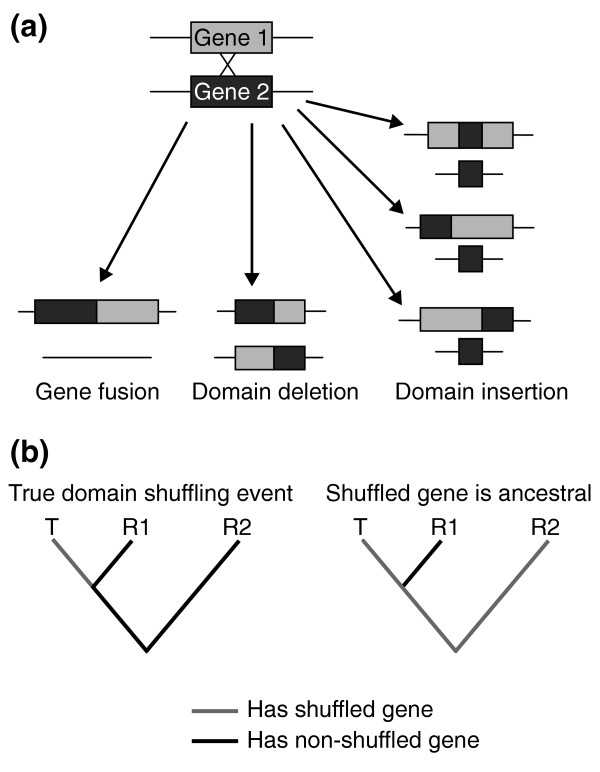
Identifying gene shuffling. (a) Gene shuffling and how it changes gene structure. The three scenarios of 'domain insertion' represent insertions of domains from gene 2 into gene 1. The reciprocal insertions (gene 1 into gene 2) are not shown. (b) Distinguishing true from spurious recombination events. In a spurious recombination event, reference genome R1 has two separate genes, where both T and R2 have a single, shuffled gene. The most parsimonious explanation for this observation is that the shuffled gene was present in R1 but was lost since R1's divergence from T.